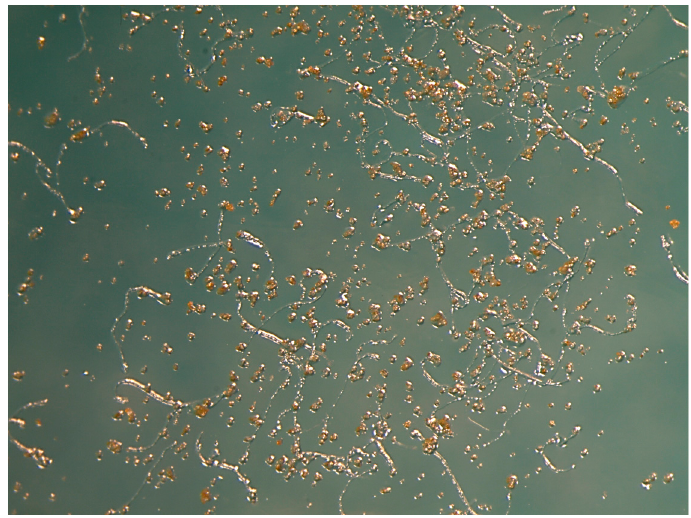
Figure 4. “Encanto” rose pollen spread on the culture medium, containing 40 mg L − 1 H 3 BO 3 ; 152 mg L − 1 CaCl 2 (H 2 O); 150 g L − 1 sucrose; 7 g L − 1 agar with a pH of 5.6, after 190 days of storage in the deep freezer (T = − 80 °C). Pollen tubes developed from the germinated pollen grains. Table 1. Hybridizations performed in 2015 NIRP International breeding plan. Rose maternal plant and pollen donor cultivars are list in the table; the number of crossings made in 2015 breeding plan, the number of collected seeds and the ratio seed/crossing are reported. Pollen in vitro germination percentages of the pollen donor cultivars are in the last column on the right letters indicate the significance of differences between genotypes as determined by one-way ANOVA and REGW-F post-hoc tests.